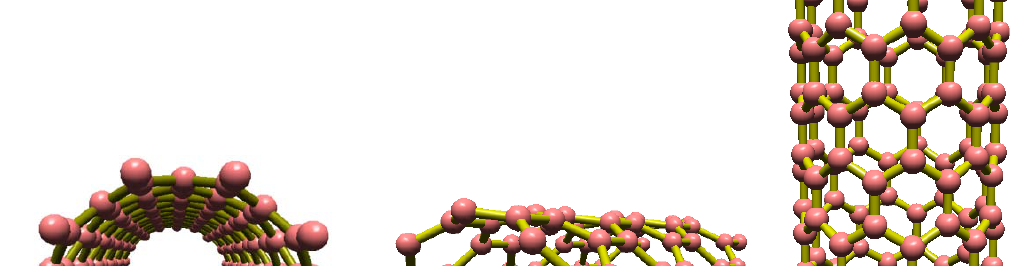
Figure 1. Single wall carbon nanotube